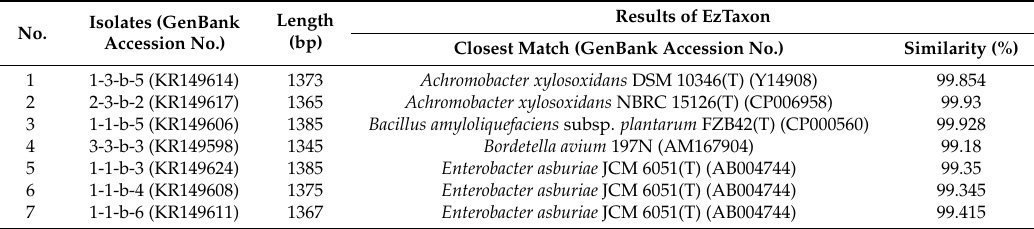
Table 3. Identification of bacterial and fungal strains isolated during solid state fermentation (SSF) of